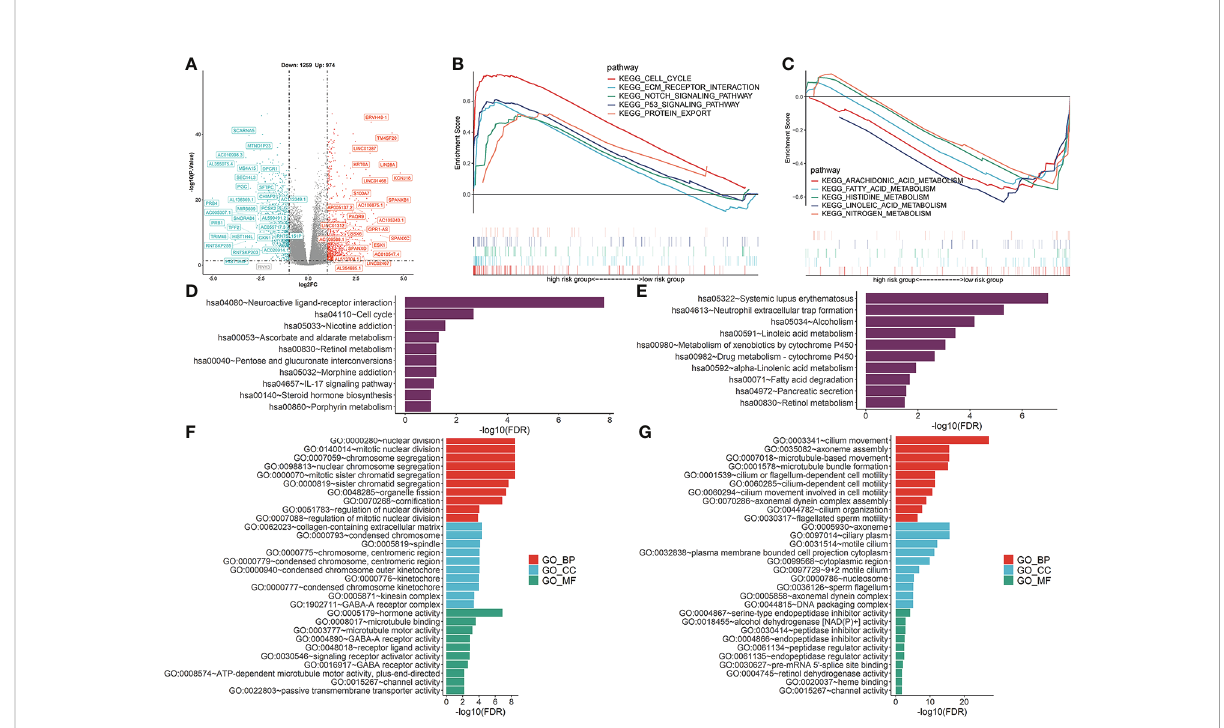
FIGURE 9 Functional analysis was performed to identify the enriched biological processes. (A) Volcano map of differentially expressed vesicle-mediated transport-related genes in TCGA-LUAD cohort. (B, C) GSEA analysis of high- (B) and low- (C) risk groups. NES: normalized enrichment scores. (D, E) KEGG analysis of high- (D) and low- (E) risk groups. (F, G) The GO enrichment analyses of high- (F) and low- (G) risk groups. BP, biological processes; CC, cellular components; MF, molecular functions.